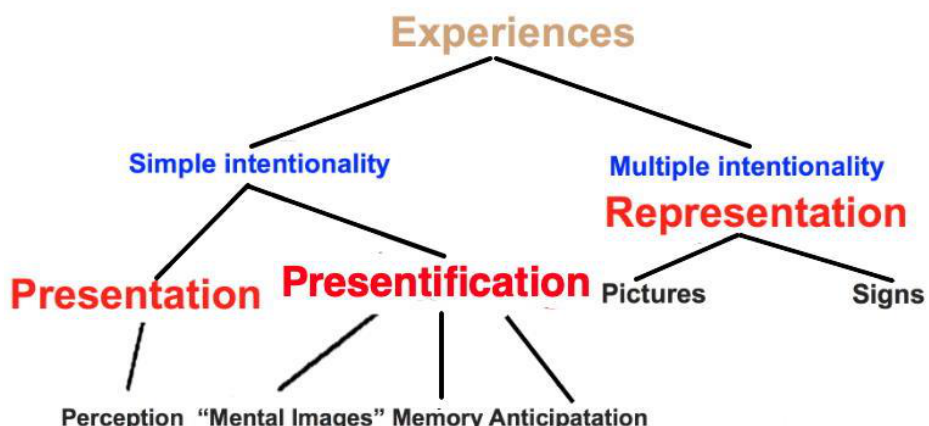
Figure 1. Husserl’s final division of psychic acts (“Vorstellungen”) in Husserl [95] (p. 139), as analysed in Sonesson [99]. Note that Husserl himself does not always clearly distinguish presentifications and representations (which he confounds in the passage referred to), but the distinction is present all through his work [95]. Colours are only used to emphasis levels of organizations.